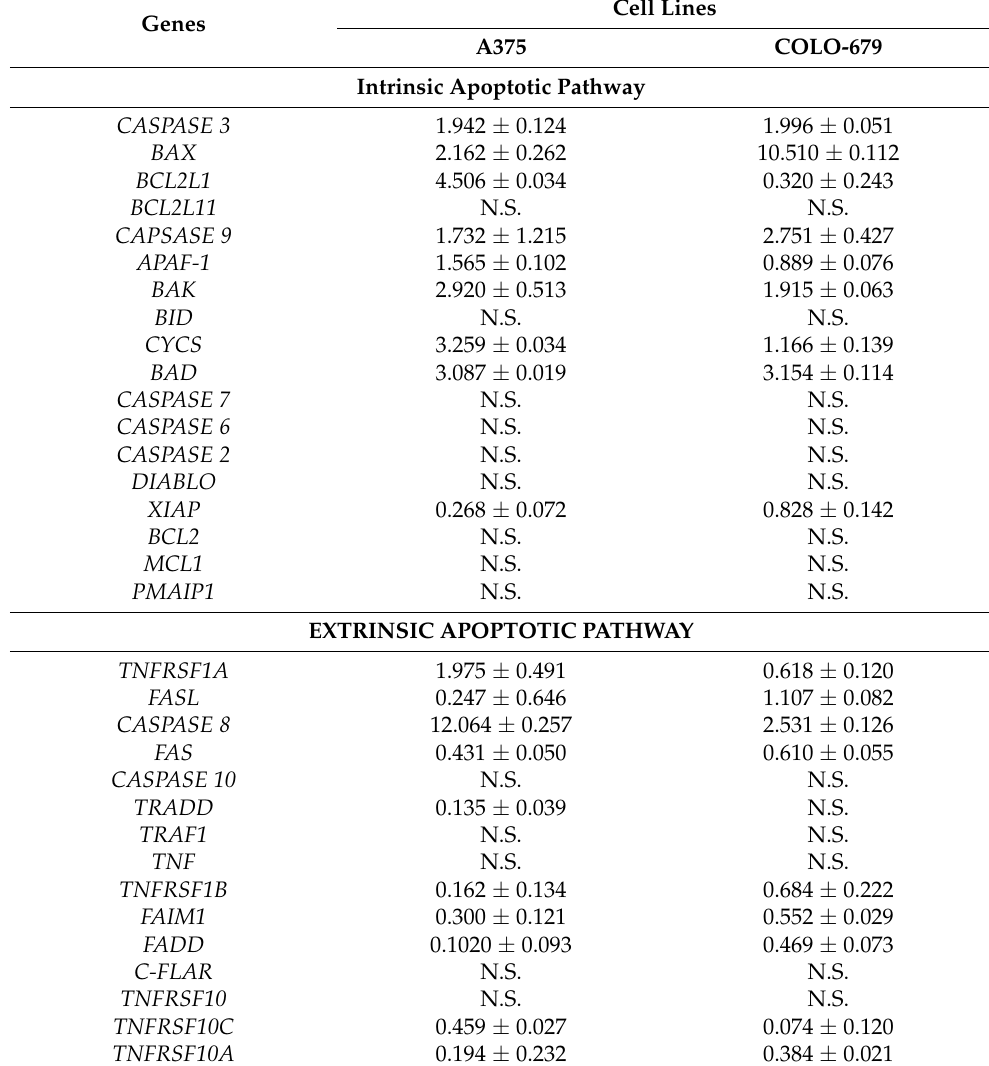
Table 4. Gene expression profiling of various intrinsic and extrinsic apoptotic genes in A375 and COLO-679 cell